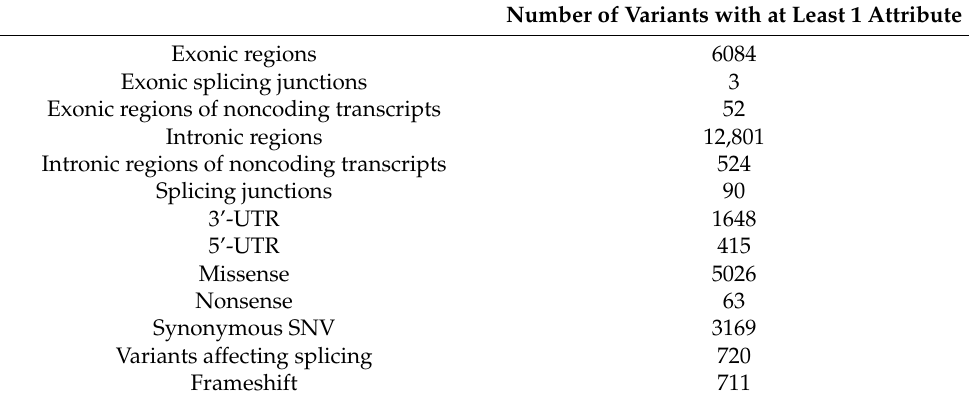
Table 1. Description of regions and types of variants uploaded in iVar.